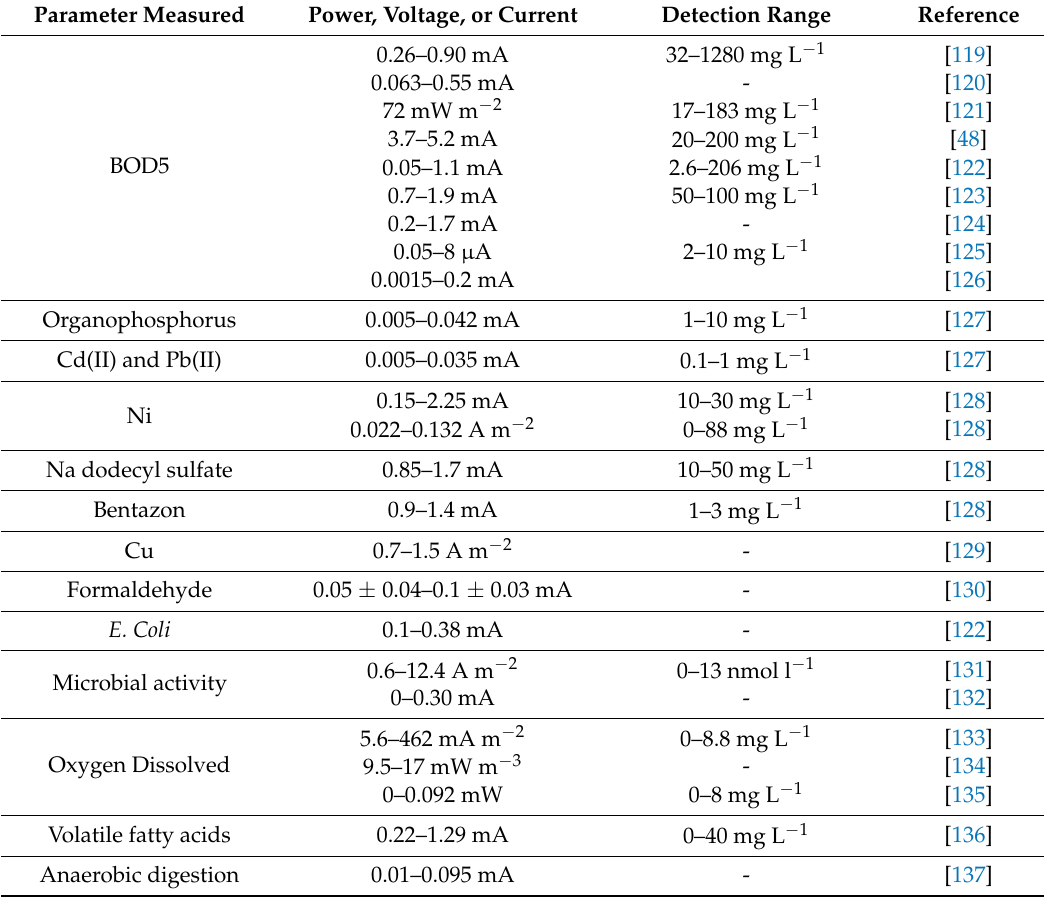
Table 1. Summary of viable reported applications of MFC-based